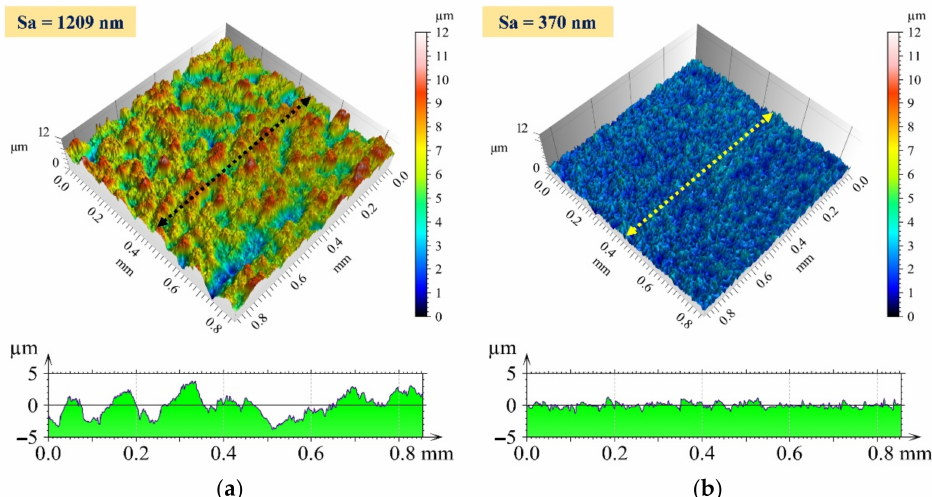
Figure 14. Three-dimensional surface profile and 2D profile curve (along the marked line in 3D image) for the chemically treated surface at ( a ) 5% HF and 30 min exposure time and ( b ) 1% HF and 30 min exposure